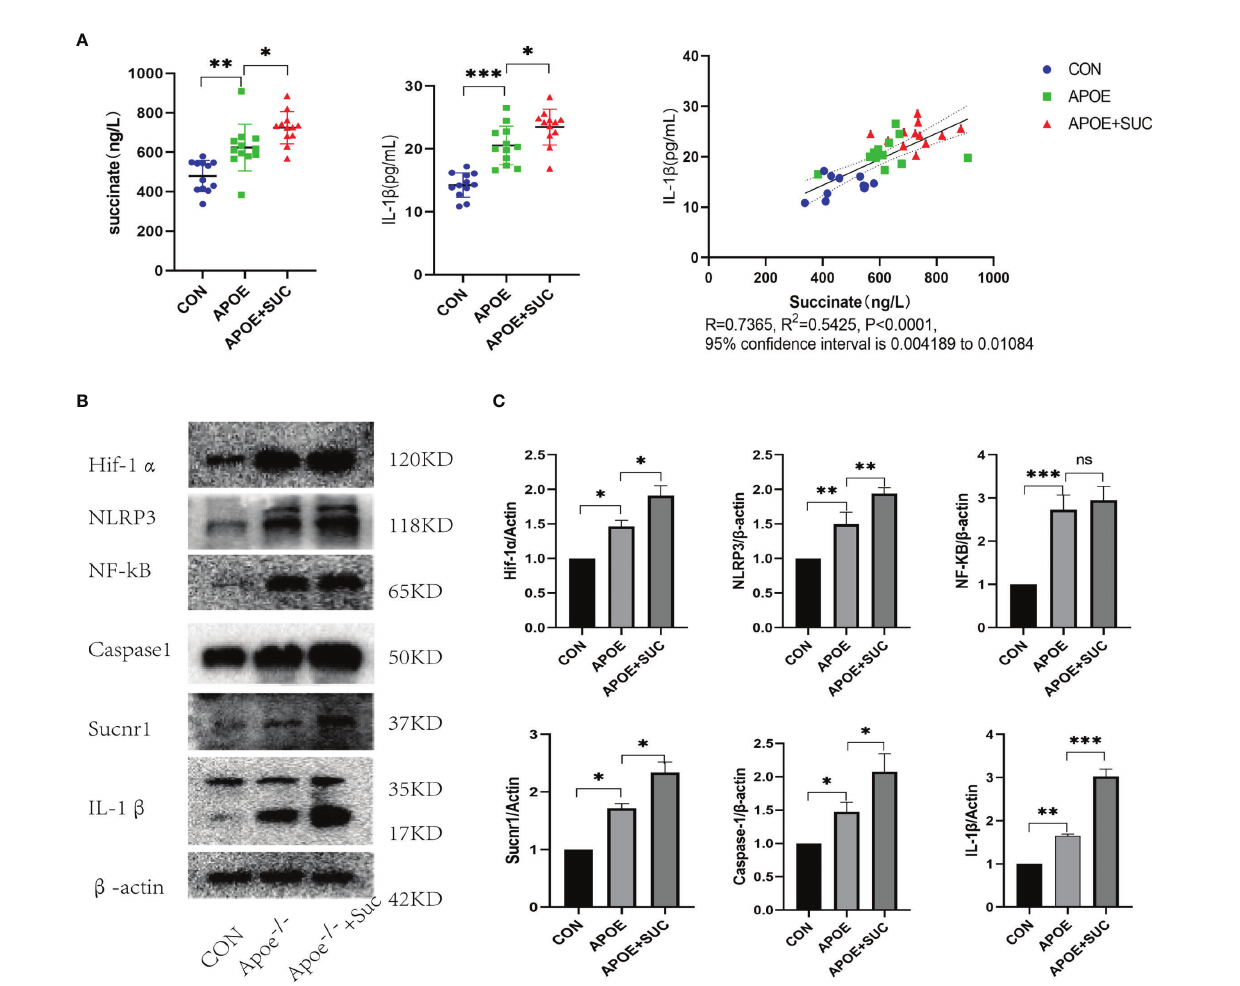
FIGURE 8 | Succinate/IL-1 b signal axis in atherosclerosis model (protein level). C57BL/6J mice were blank control (CON), while Apoe -/- mice were randomly divided into two groups (Apoe -/- group and Apoe -/- +Suc group). For each mouse, the artery from heart to iliac artery was dissected and kept. (A) Succinate and IL-1 b of serum were detected by ELISA. ELISA results were mean ± SD from at least three different experiments. * P < 0.05; ** P < 0.01; *** P < 0.001. (B, C) Expression levels of succinate/IL-1 b signal axis and NF- k B were tested by Western blots. Western blot data present mean ± SEM from three independent experiments at least. * P < 0.05; ** P < 0.01; *** P < 0.001; ns means no statistical